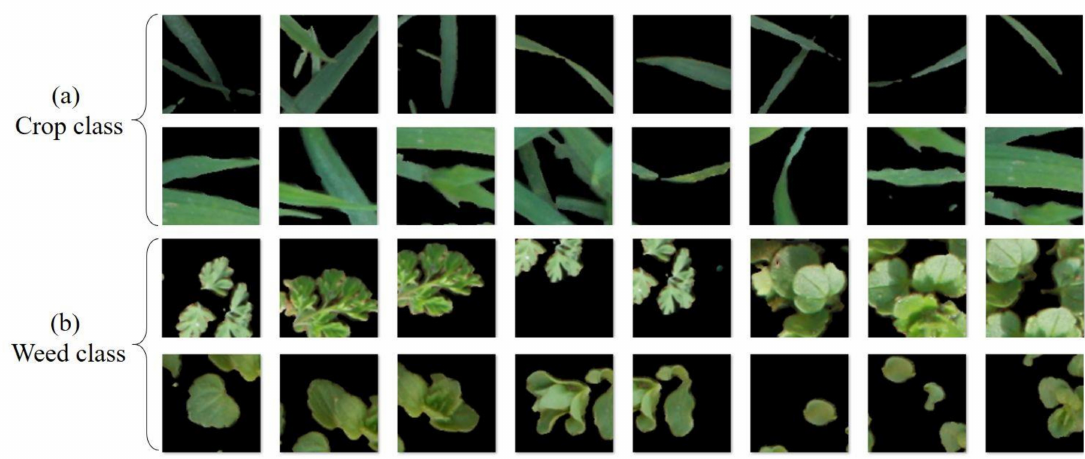
Figure 3. Sample thumbnail images for each class (weed and crop) used to create the training dataset: ( a ) Wheat; ( b ) Weeds. These thumbnails are extracted from the labelled image database built on di ff erent